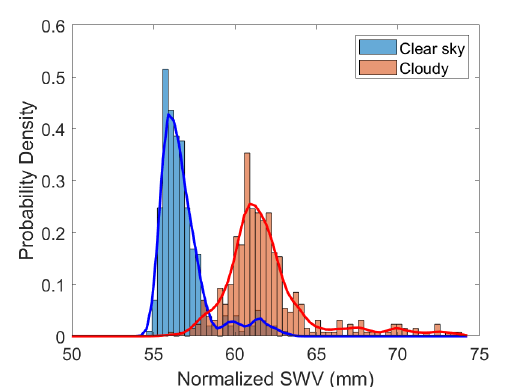
Figure 11. Probability density of normalized SWV associated with clear sky and cloudy conditions on 16 April 2016.